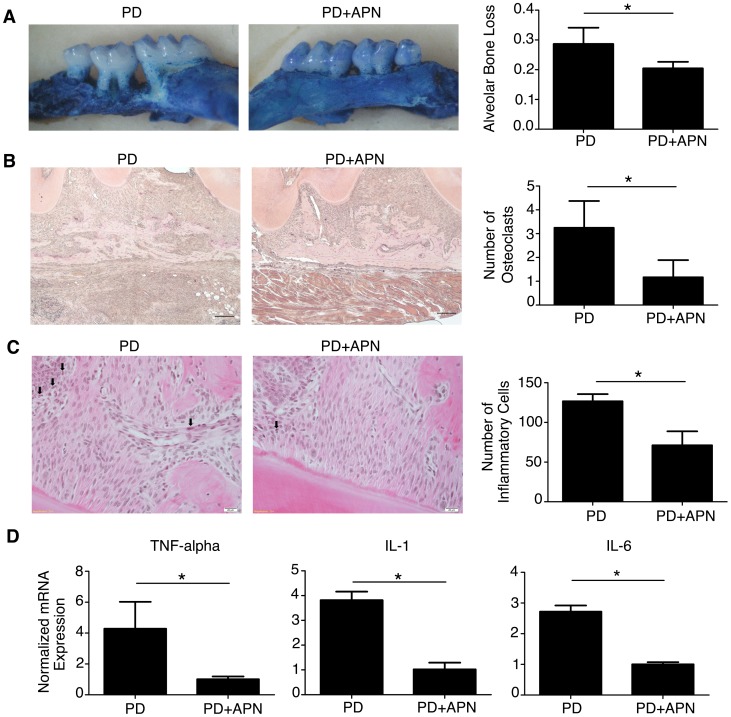
APN Inhibits Bone Resorption and Inflammation in DIO Mice Induced With Experimental Periodontitis.(A) Alveolar bone loss was determined in palatal bone samples stained with 1% methylene blue and photographed at 30× magnification using a dissecting microscope with the occlusal face of the molars perpendicular to the base. The distance between the cementoenamel junction and the alveolar crest was measured at 6 sites in DIO+PD and DIO+PD+APN mice (magnification, ×30). (B) TRAP staining determined the number of osteoclasts (magnification, ×200; scale bars, 500 µm). (C) H&E staining determined the number of inflammatory cells of palatal bone samples in DIO+PD and DIO+PD+APN mice (magnification ×400; scale bars, 20 µm; black arrows = inflammatory cells). (D) qRT-PCR of TNF-α, IL-1, and IL-6 mRNA levels in WAT from DIO+PD and DIO+PD+APN mice, normalized to GAPDH. Data are shown as mean ± SD (n = 5). *P<0.05.